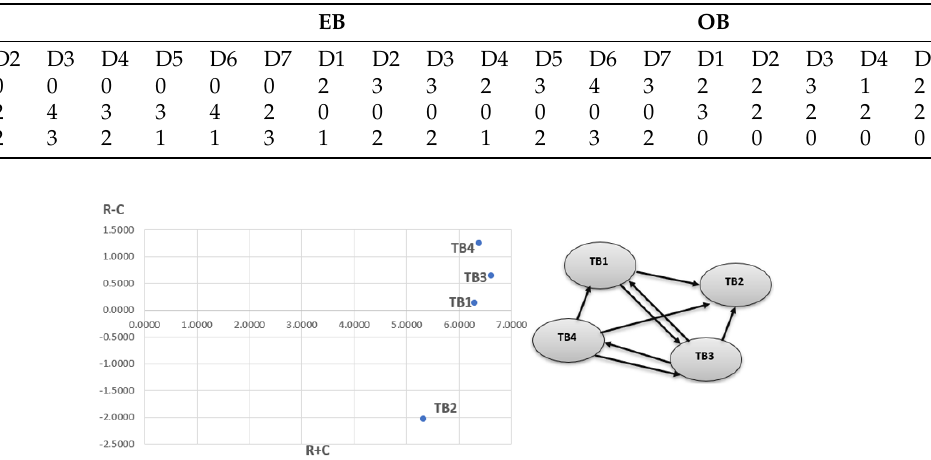
Figure A1. The causal effect graph for the technological and system